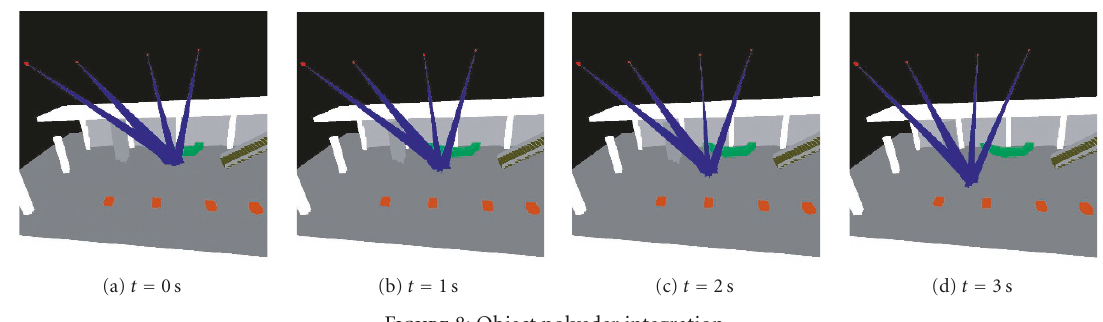
Figure 8: Object polyeder integration. Figure 10 refers to a path planning experiment where a path adaption process was performed between two fixed po- sitions on the floor plane. The initial path planning method gives a first solution to the problem and further on